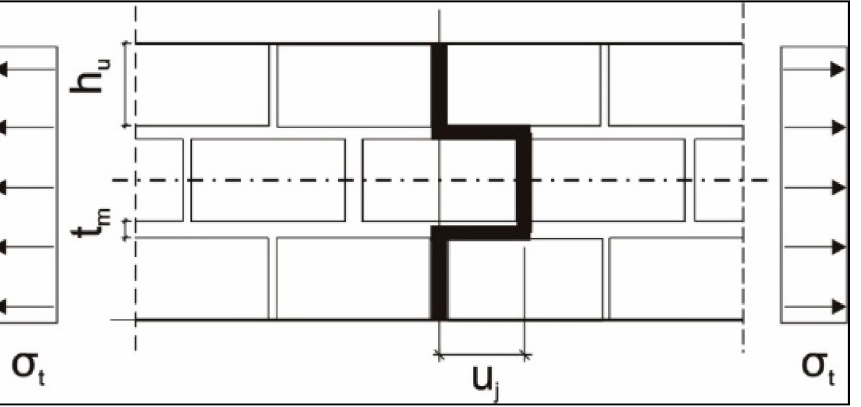
Figure 5. Destruction of the masonry wall sample exposed to axial tension with cracking along only the joints.